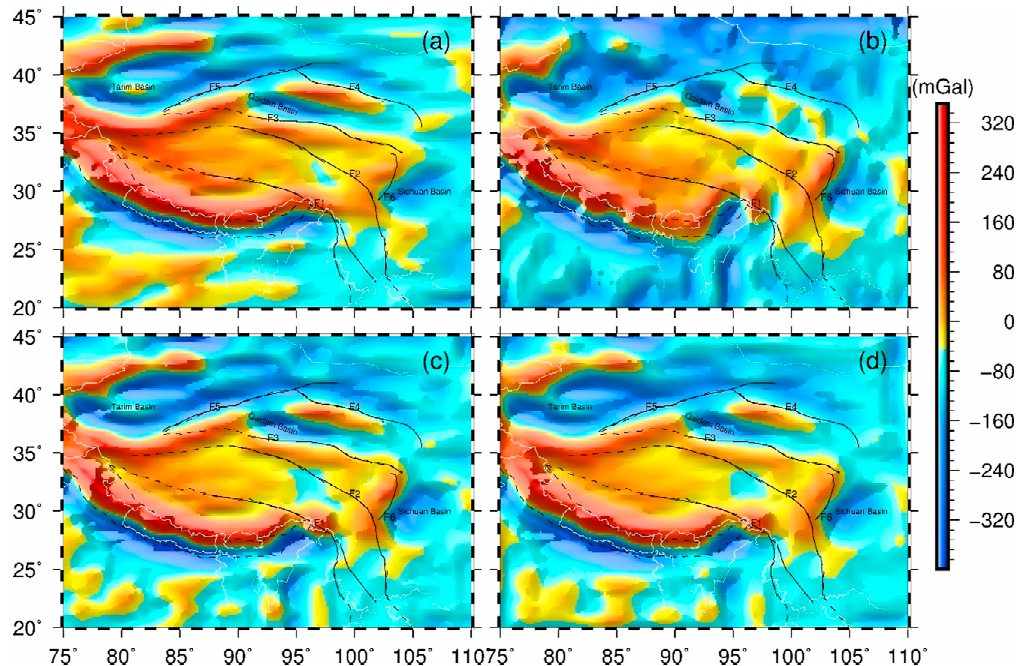
V ; ( c ) V ; ( d ) joint inversion V ; ( b ) yy rr xx